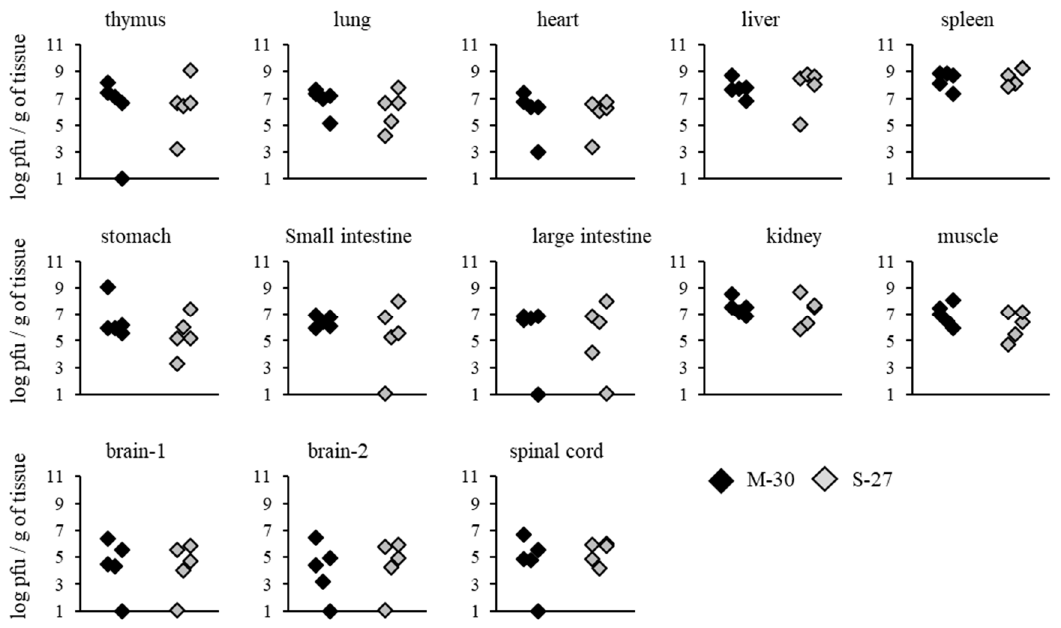
Figure 5. Viral loads in tissues of AG129 mice at 2 days after subcutaneous infection with 10 2 PFU of the M-30 and S-27 CHIKV